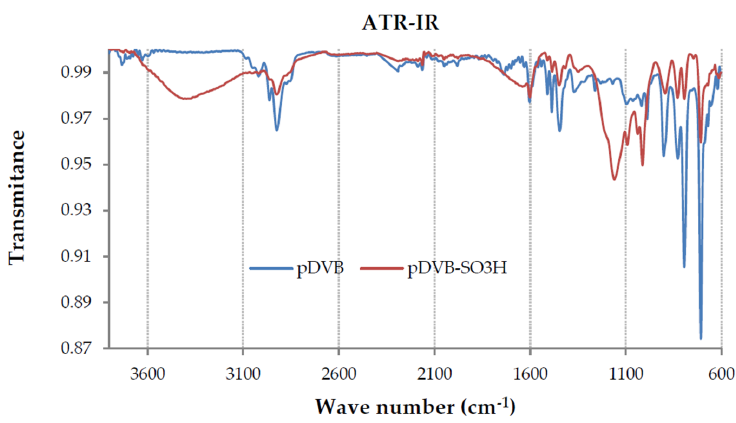
Figure 1. The ATR-FTIR spectra of pDVB and pDVB-SO 3 H polymers.